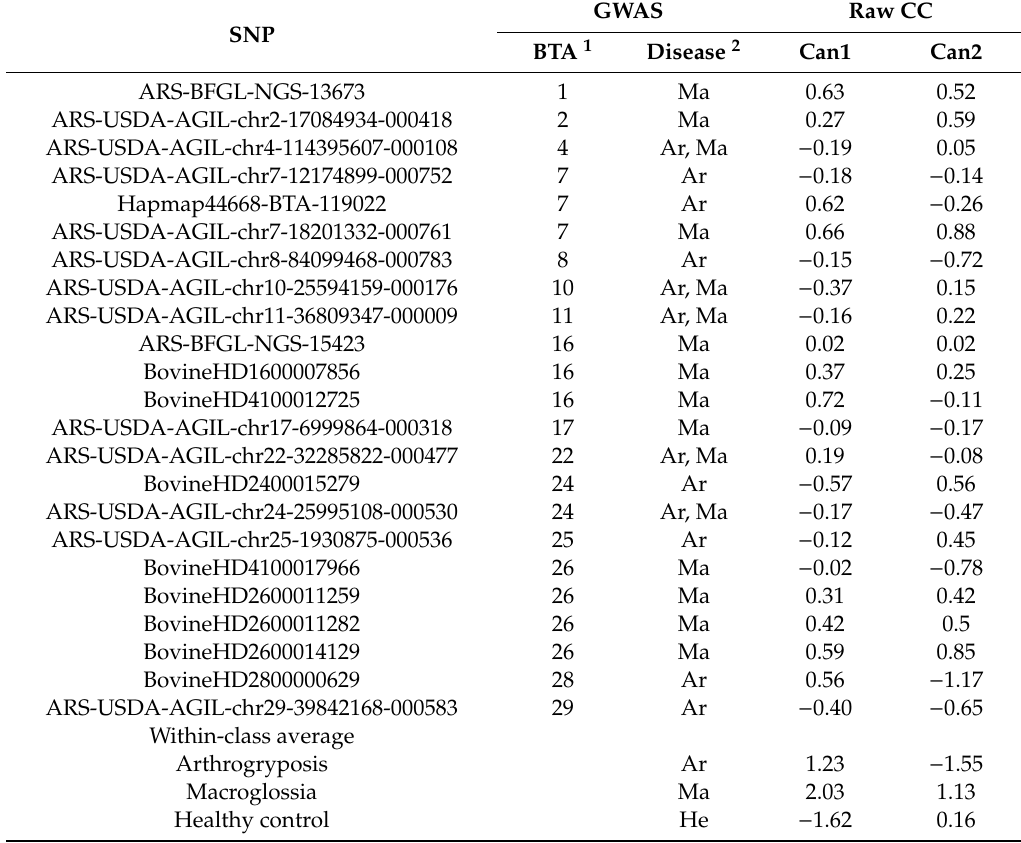
Table 1. Relevant markers found by the genome-wide association study (GWAS) and F ST analysis and raw canonical coe ffi cients (CC) associated to significant single nucleotide polymorphisms (SNPs). Within-class average scores for the two discriminant functions (Can1 and Can2). CC: canonical coe ffi cients. GWAS Raw CC SNP BTA 1 Disease 2 Can1 Can2 Ma